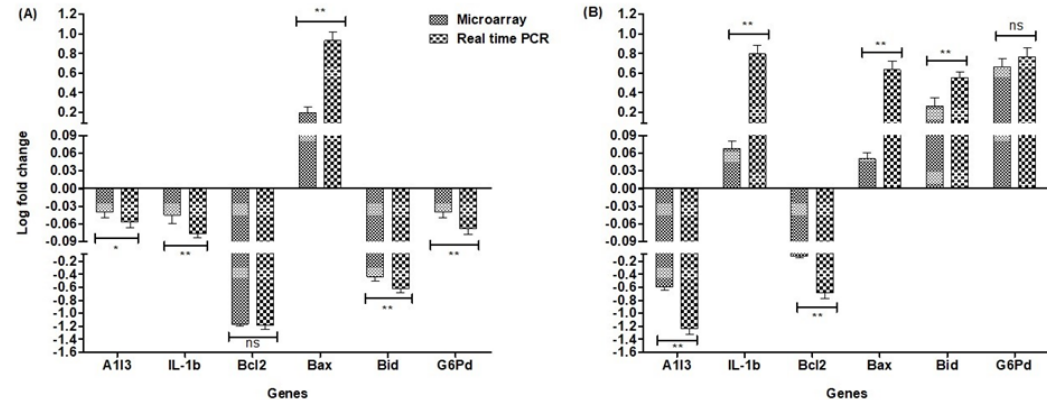
Figure 1. Relative expression of six candidate genes from the brain and liver tissue using real-time PCR and Microarray: ( A ) the comparative expression of genes in the brain; ( B ) the comparative expression of genes in the liver. Relative gene expressions were normalized by comparison with the expression of the Glyceraldehyde 3-phosphate dehydrogenase (GAPDH) gene, while results were analyzed using the 2 −ΔΔCT method. For each gene, all RT-qPCRs used five biological replicates, with three technological replicates per experiment. The non-parametric Mann–Whitney U test was used to compare the pairwise expression of the microarray and the RT-PCR expression for the respective genes. We evaluated the normality of the data using the Kolmogorov–Smirnov normality test. Error bars indicate a ±SE value. * p < 0.05, ** p < 0.001, ns = non-significant.